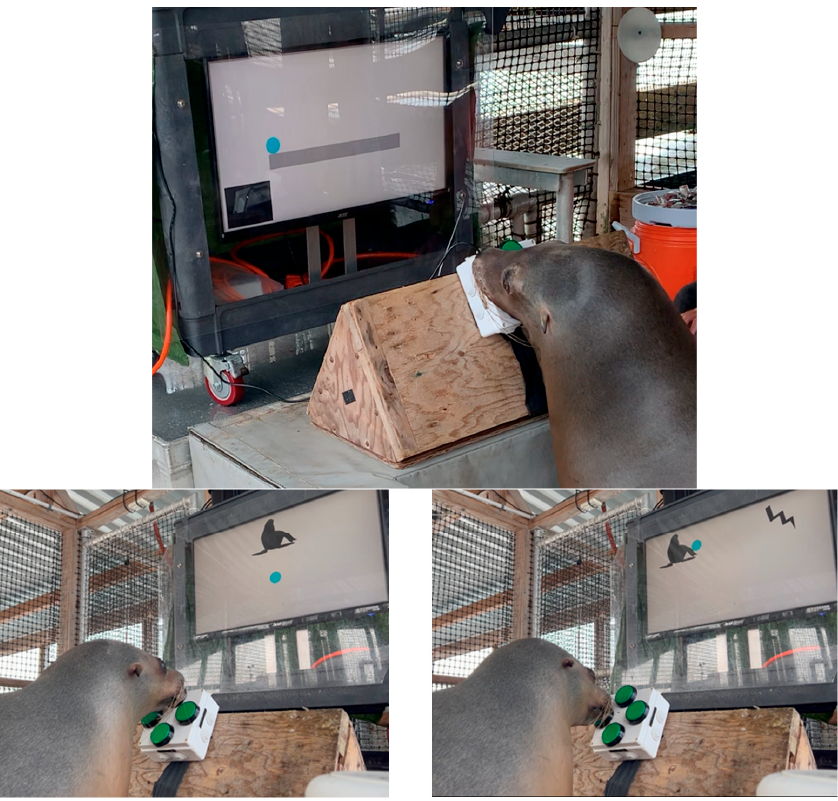
Figure 3. Example of a MAZE introductory training trial ( top ), a MTS S+ presentation screen ( bot- tom left ), and a MTS choice screen with the S+ and S- ( bottom right